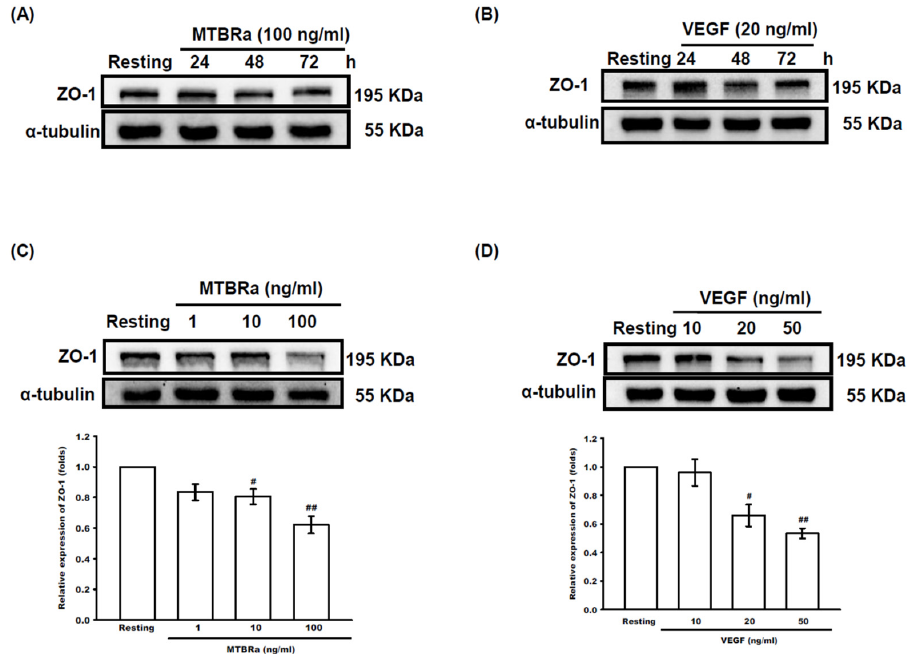
Figure 5. MTBRa and VEGF downregulate ZO-1 expression in human PMCs. MeT-5A cells were treated with ( A ) MTBRa and ( B ) VEGF for the indicated times or stimulated with various concen- trations of ( C ) MTBRa (1–100 ng/mL) and ( D ) VEGF (10–50 ng/mL) for 48 h. ZO-1 expression was analyzed by Western blotting. Data represented three independent experiments. # p < 0.05, ## p < 0.01 compared with resting group. MTBRa, Mycobacterium tuberculosis H37Ra; VEGF, vascular endothelial growth factor; ZO-1, zonula occludens; PMC, pleural mesothelial cell.